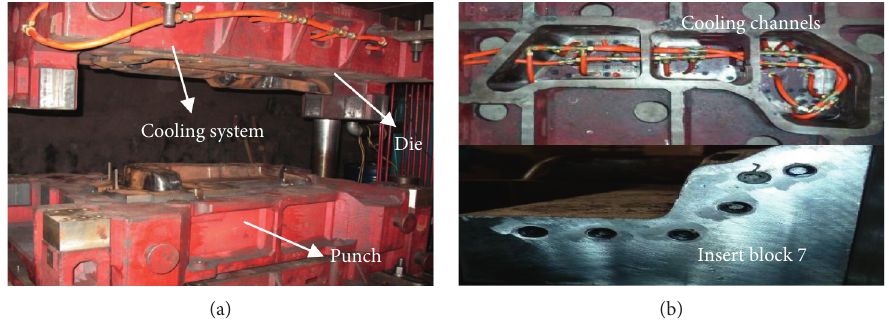
Figure 12: Die structure and cooling system of the synchronous quenching process: (a) die structure; (b) cooling system of the synchronous quenching process.